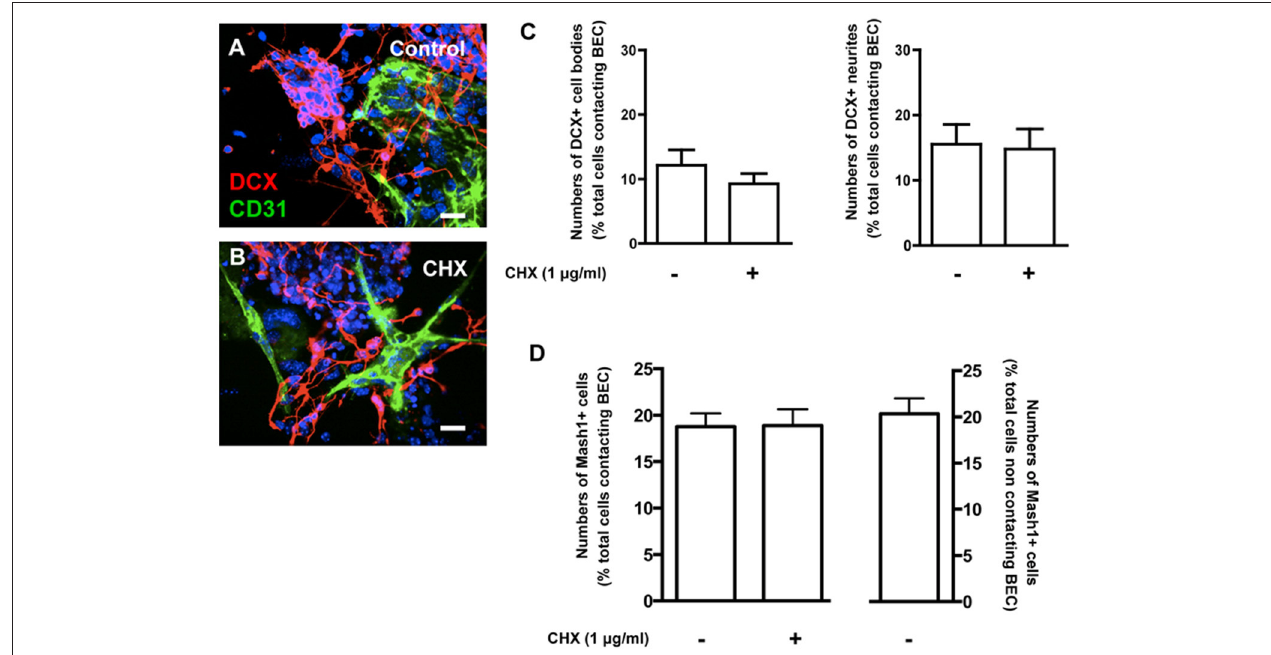
FIGURE 5 | Contacts between SVZ cells and BEC do not affect neuronal differentiation from SVZ cells. (A,B) Representative confocal digital images depicting DCX + cells in BEC and SVZ cells cocultures (green staining for CD31, an endothelial cell marker, red staining for DCX, a marker of migrating neuroblasts, and Hoechst 33342 staining in blue). (A) Control cocultures, (B) Cocultures with CHX-treated BEC. Scale bars, 20 µ m. (C,D) Bar graph shows the number of DCX + cell bodies (left portion of the graph) and neurites (right portion of the graph) (C) and Mash1 + cells (D) as a percentage of the total cells contacting BEC in Control and in CHX-treated